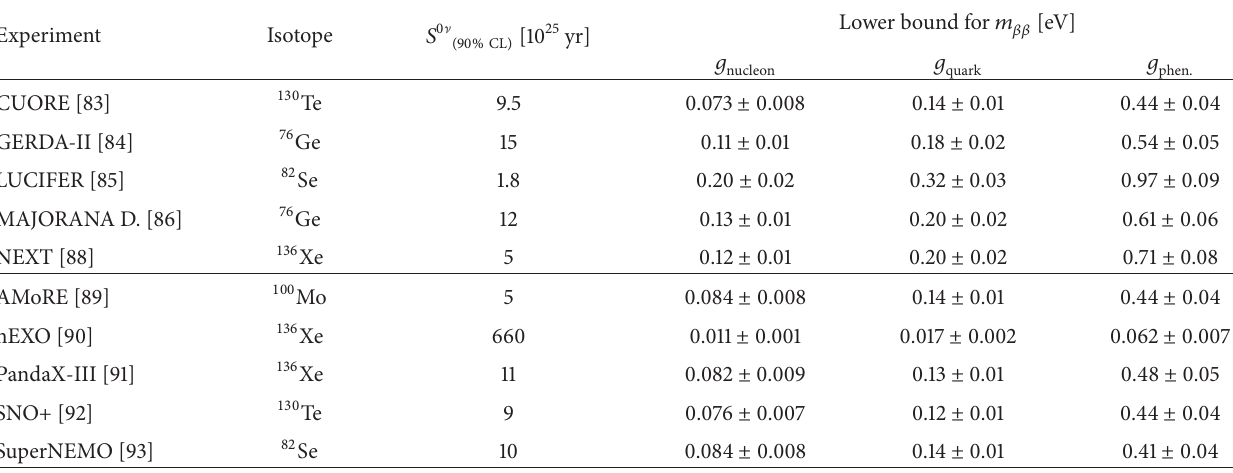
Table 9: Lower bounds for 𝑚 𝛽𝛽 for the more (upper group) and less (lower group) near future 0 ] 𝛽𝛽 experiments. References [95] and [96] were used for the PSFs and for the NME, respectively. The different results correspond to different values of 𝑔 𝐴 according to (47). Experiment